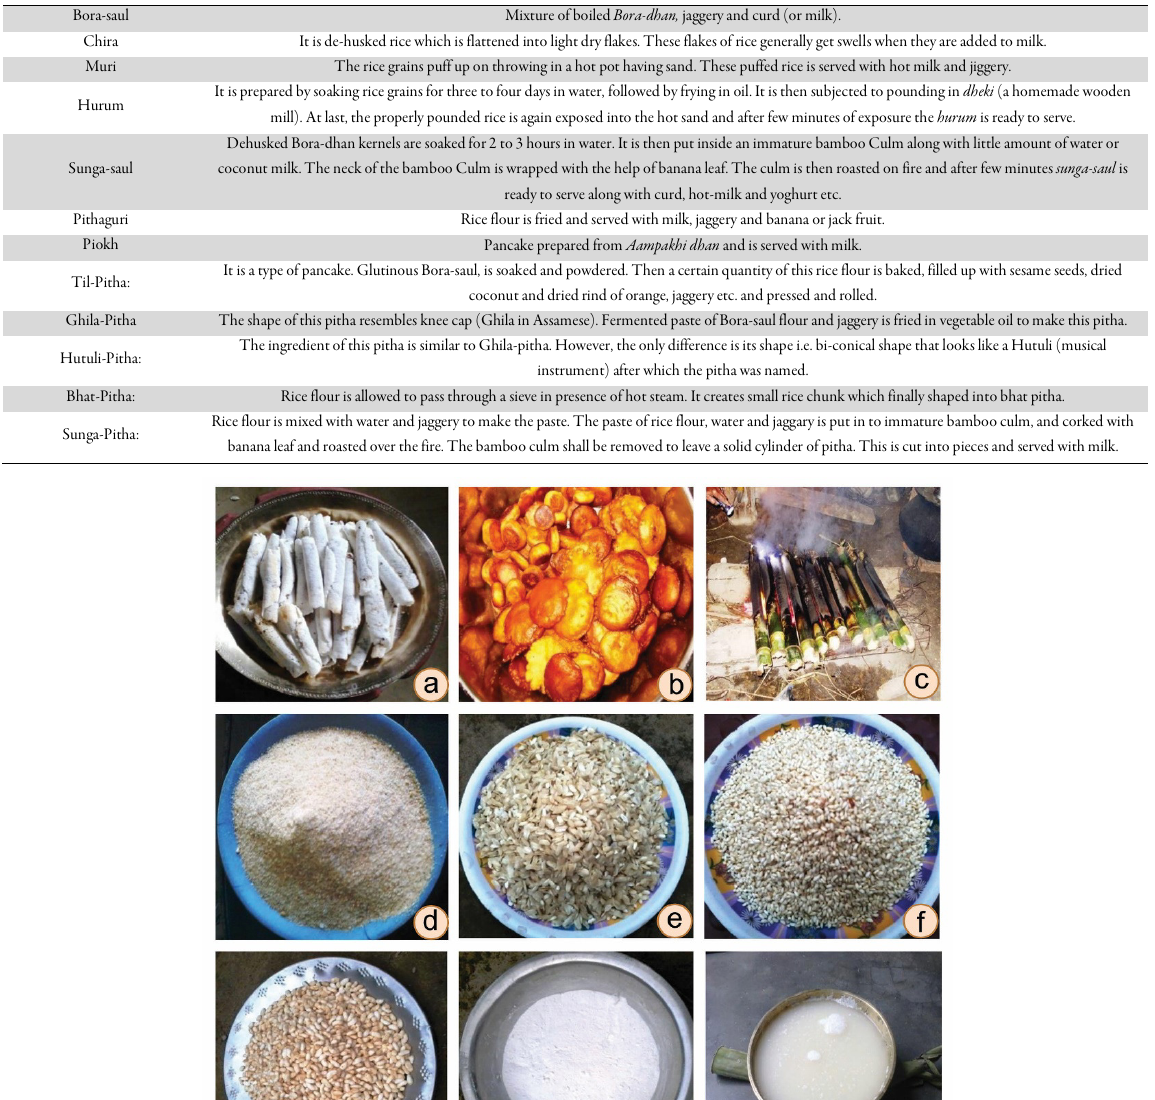
Table 3. Rice based traditional cakes, snacks and sweets of Lakhimpur, Assam, India Food Items Description